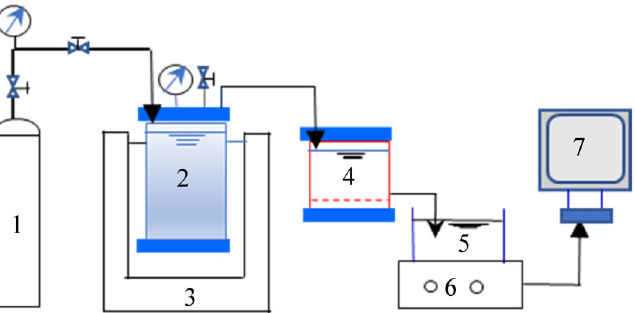
Figure 1. Schematic diagram of the filtration setup, 1. Nitrogen cylinder, 2. 4 L water vessel, 3. Low temperature storage tank, 4. Membrane filtration vessel, 5. Effluent, 6. Electronic balance, 7. Data